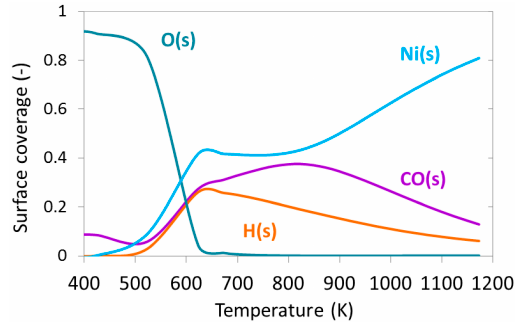
Figure 15. Computed surface coverage of adsorbed species as function of the temperature for methane dry reforming with H 2 O co-feed: 1.7 vol.% CH 4 , 2.1 vol.% CO 2 , 2.1 vol.% H 2 O in N 2 ; 1 bar; T inlet = 373 K; total flow rate of 4 slpm.